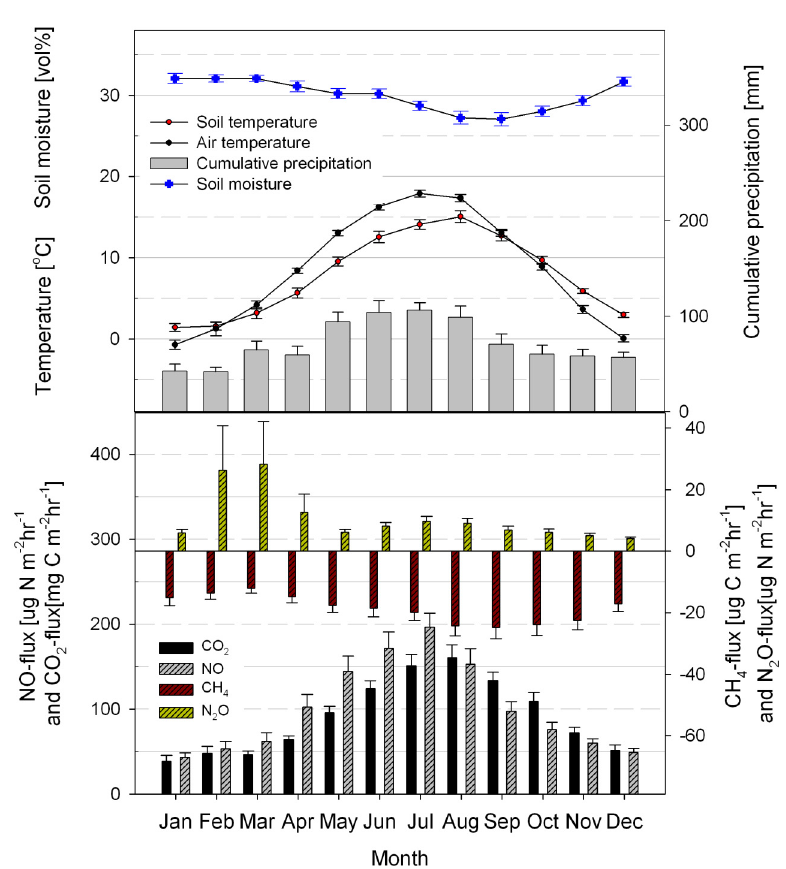
Fig. 3. Average seasonal variability of both environmental drivers and trace gas fluxes for the observation period 1994–2010. Top panel: monthly means ( ± SE) of air- and soil- temperature (5cm), soil moisture (10cm) and the average sum of monthly precipitation. Lower panel: Monthly means of trace gas fluxes ( ± SE). All SE values were calculated from monthly mean values.